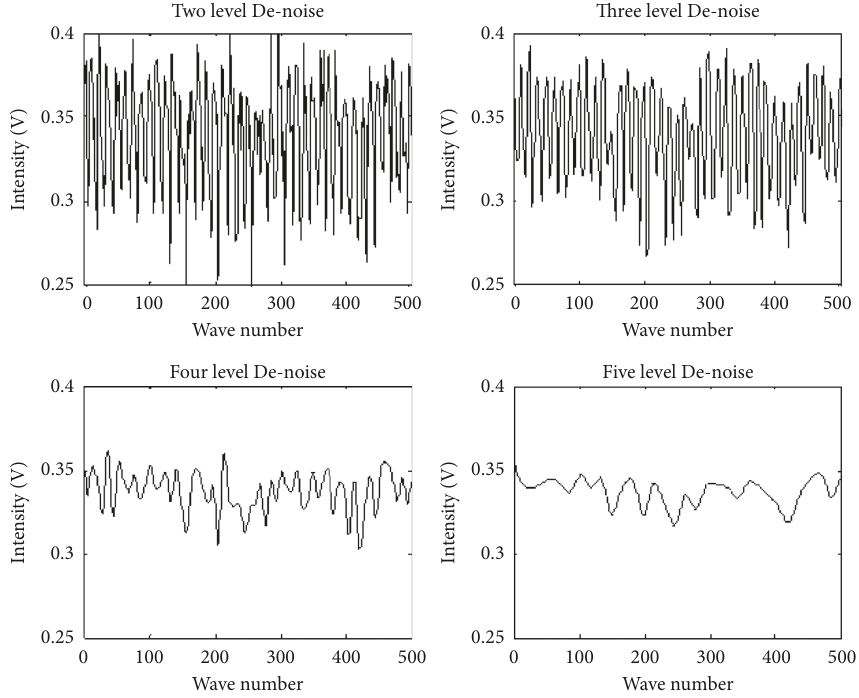
Figure 7: 2, 3, 4, and 5-layer wavelet packet decomposition denoising